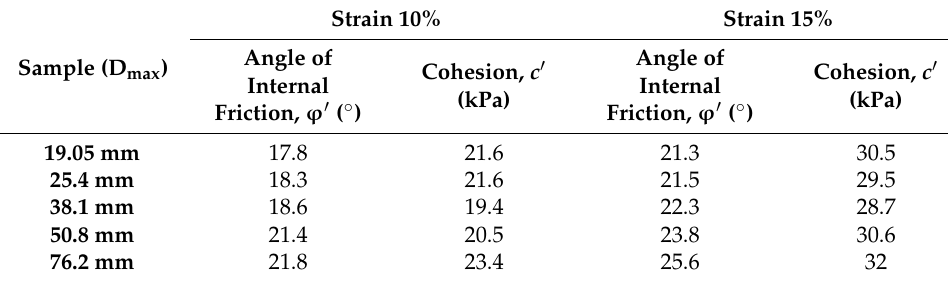
Table 3. The shear strength parameters for the five samples.